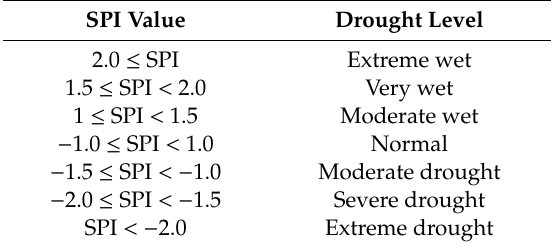
Table 4. Dryness and wetness severity classifications according to SPI